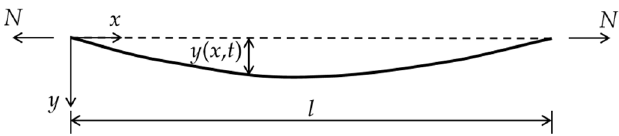
Figure 1. Cable vibration analysis model.